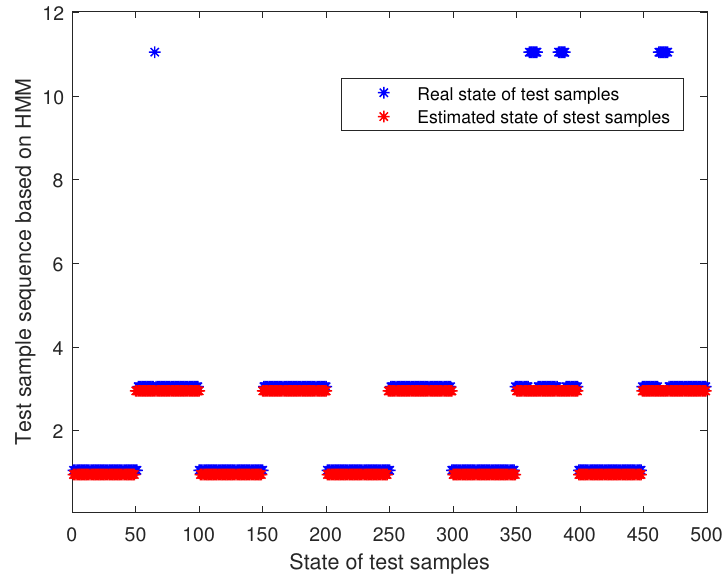
Figure 2. Comparison diagram of real state and estimated state of test samples based on HMM.